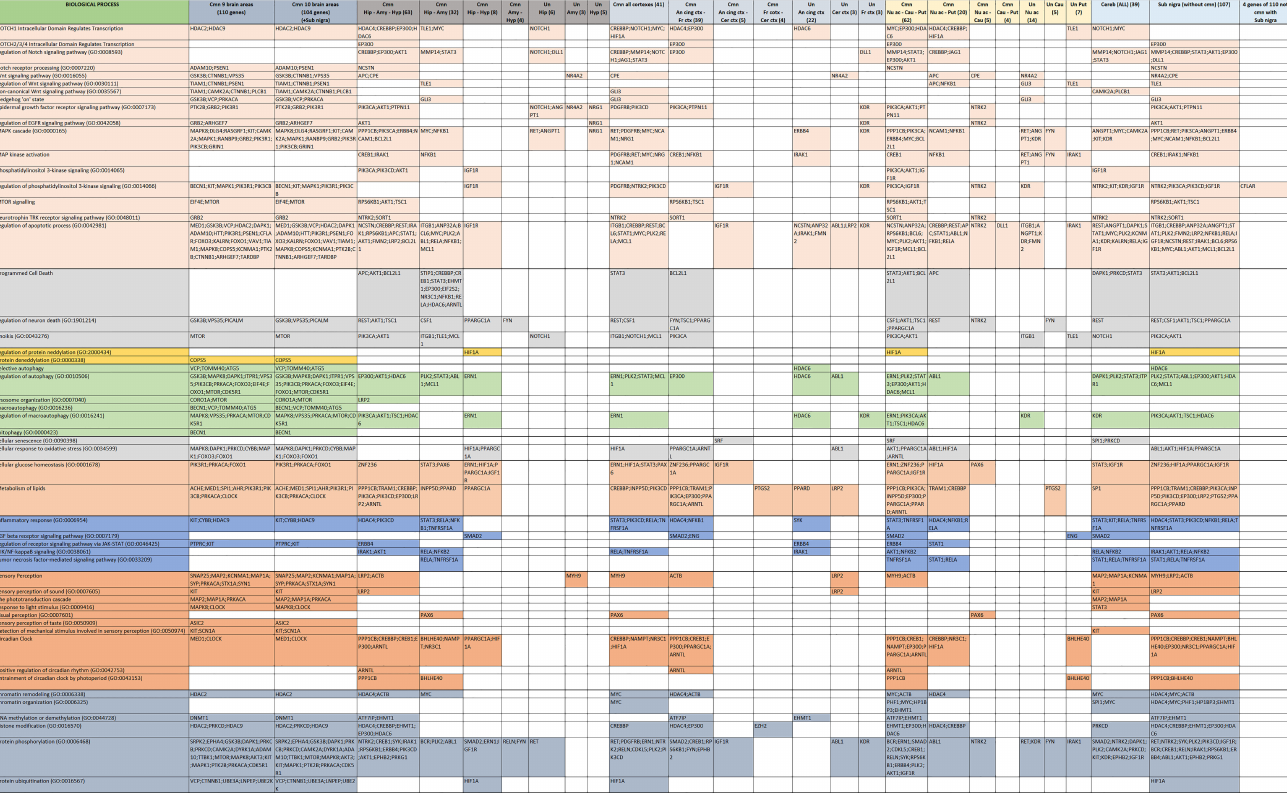
Figure 7. Selected results of biological functions involved in cellular signaling and regulation, metabolism, inflammation, perception and the